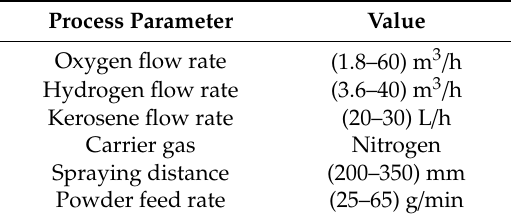
Table 1. Summary of the HVOF process parameters